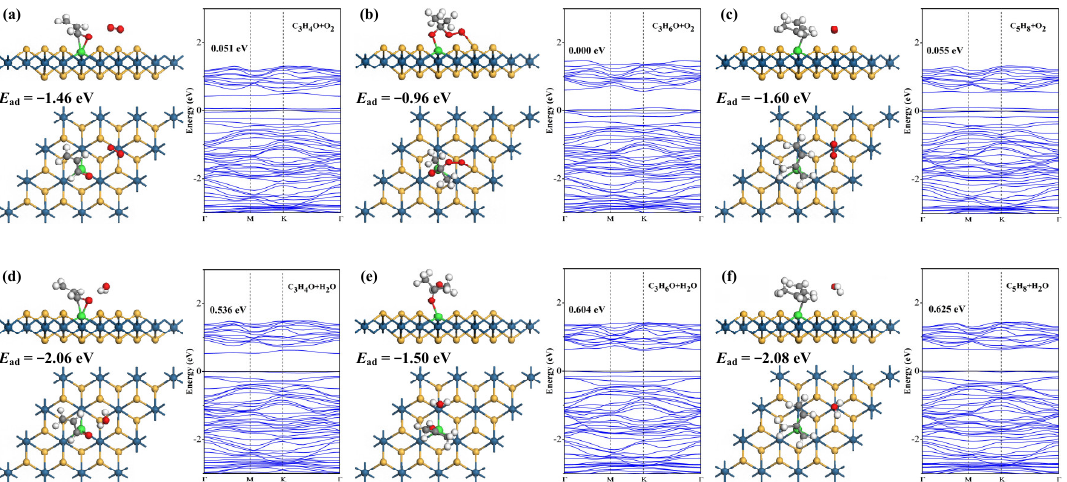
Figure 6. Gases’ co-adsorption configurations and BS of O 2 (or H 2 O) and VOCs: ( a ) C 3 H 4 O/O 2 system, ( b ) C 3 H 6 O/O 2 system, ( c ) C 5 H 8 /O 2 system, ( d ) C 3 H 4 O/H 2 O system, ( e ) C 3 H 6 O/H 2 O system and ( f ) C 5 H 8 /H 2 O system.